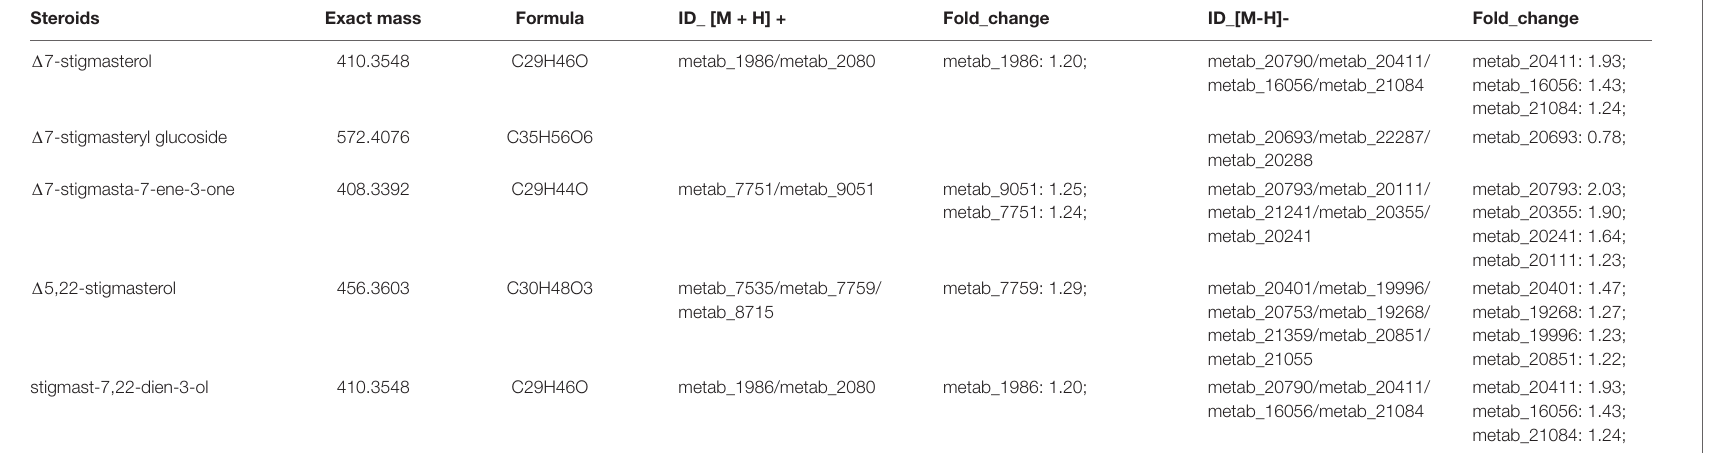
TABLE 6 | Differentially expressed metabolites (DEMs) annotated as